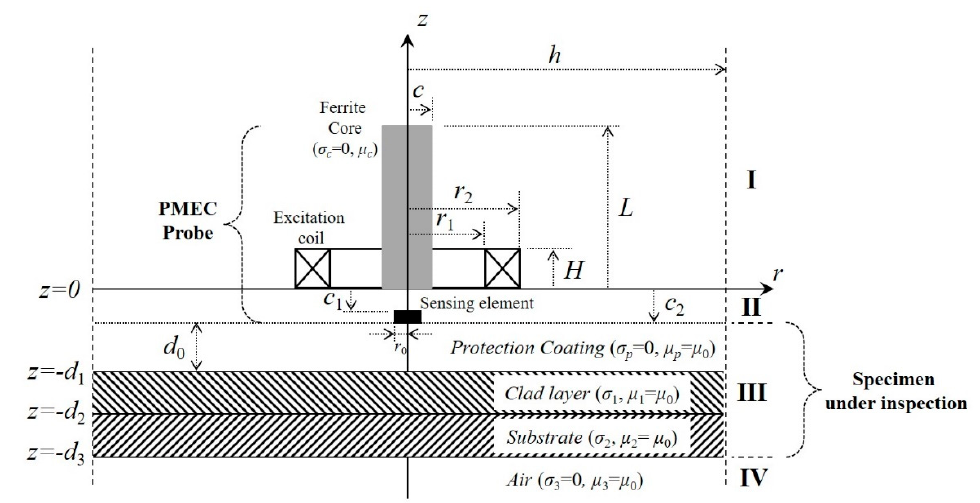
Figure 1. The 2D axisymmetric model of a ferrite-cored pulse-modulation eddy current technique (PMEC) probe placed over the protective coating of a cladded conductor.